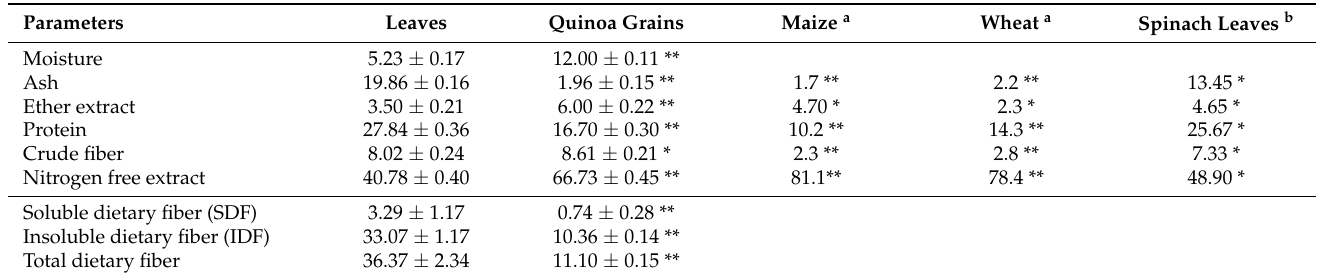
Table 1. Comparison of proximate composition and dietary fiber content of quinoa leaves with quinoa grains and other plant species (g/100 g dry weight of the sample).